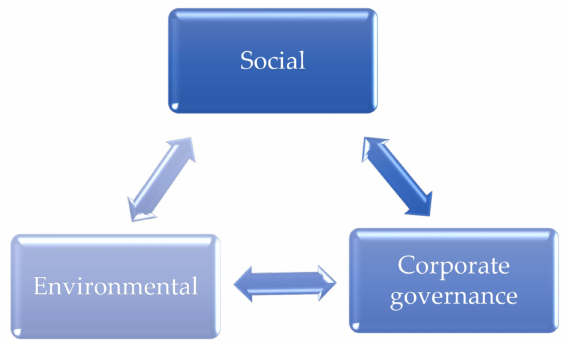
Figure 1. Aspects of corporate social responsibility.